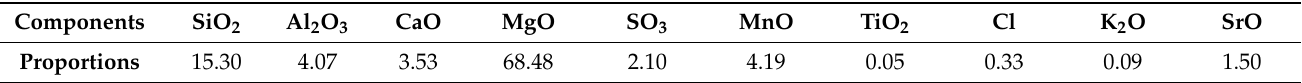
Table 2. Chemical composition of cement (%).